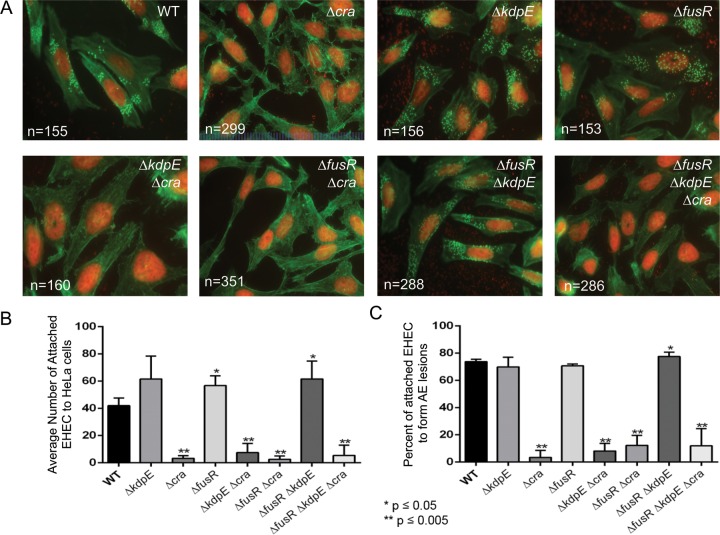
AE lesion formation in deletion strains. (A) All DNA is stained red (bacteria and HeLa cell nuclei). AE lesions are green (actin) cups beneath red bacteria. The number of quantified HeLa cells is indicated. (B) Quantification of the average number of bacteria attached per HeLa cell. (C) Quantification of the percentage of attached bacteria to form an AE lesion. The standard deviation is indicated. P values were calculated with Student’s t test. *, P ≤ 0.05; **, P ≤ 0.005.